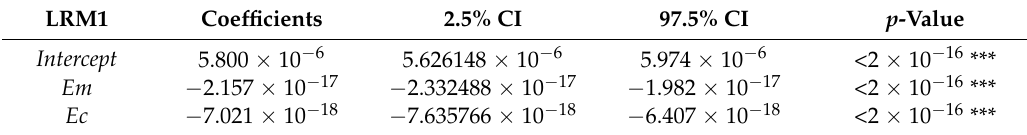
Table 4. Regression Statistic: case 3.2.1—Thinner core.